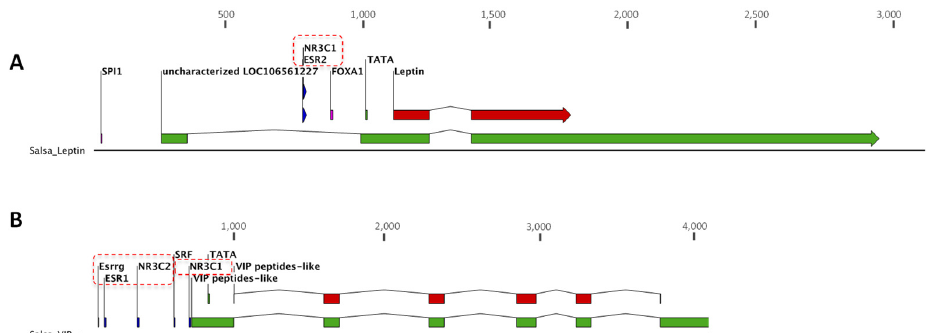
Figure 6. Binding sites of steroid receptor in Lep and VIP genes. The organization of nucleotide sequence of Lep ( A ) and VIP genes ( B ) of Atlantic salmon are shown. The nucleotide region that encodes the mRNA is indicated in green. In the case of VIP mRNA, only a partial 3 ′ -sequence is shown. The red box indicates the different exons of the respective coding sequences. The location of putative sequences corresponding to binding sites recognition of nuclear receptors of steroid hormones is remarked in both nucleotide sequence draws.